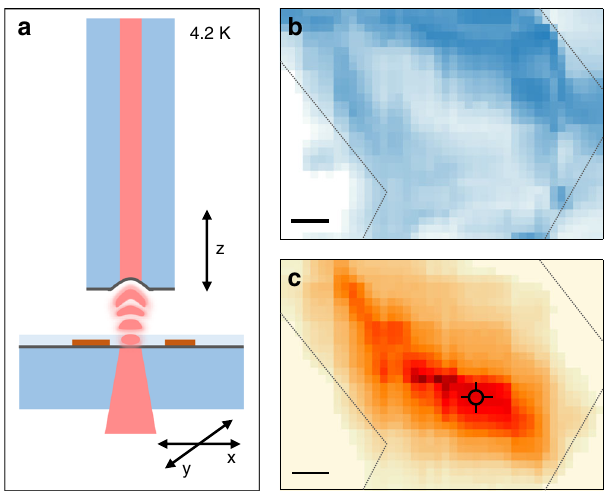
Fig. 3 a Cavity setup at 4.2 K: the fi ber-based micro-mirror forms the cavity together with a planar macro-mirror with CVD-grown MoSe 2 -WSe 2 heterostructure on top. Independent translational degrees of freedom enable lateral sample displacement and cavity length detuning. b Transmission map recorded through the cavity with laser excitation at 635 nm (blue color corresponds to reduced transmission due to local variations in absorption and scattering). c Map of integrated PL intensity recorded simultaneously with the transmission map (dark red color represents maximum intensity). The cross indicates the position on the fl ake used in the measurements of Figs. 2 and 4, the gray dashed lines indicate the boundaries of the fl ake. The scale bar is 10 μ m in both maps